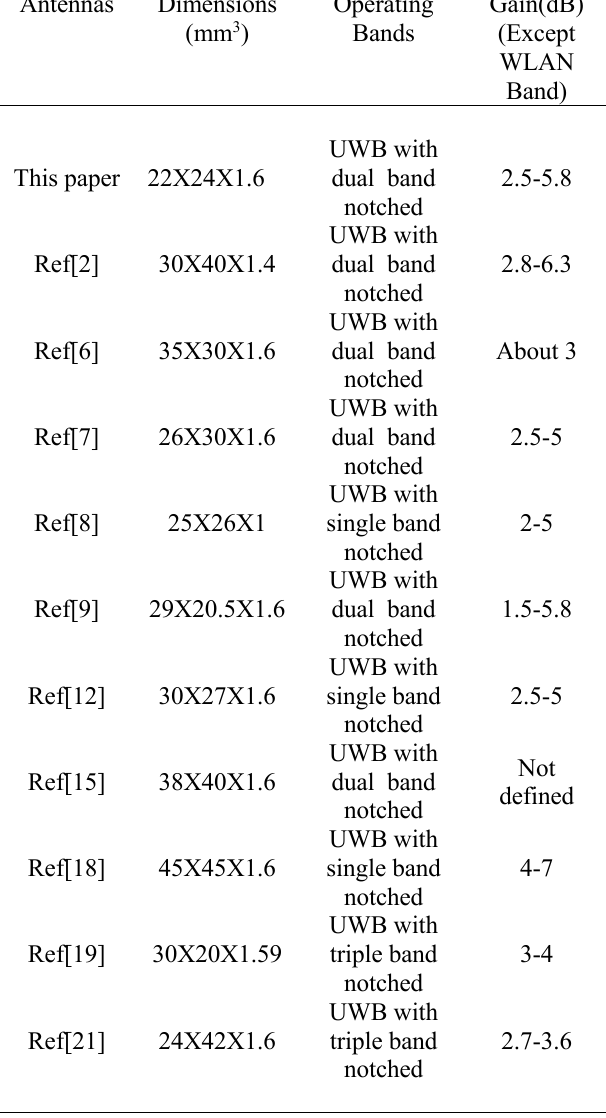
Table 1: Comparison between recently proposed antennas and this